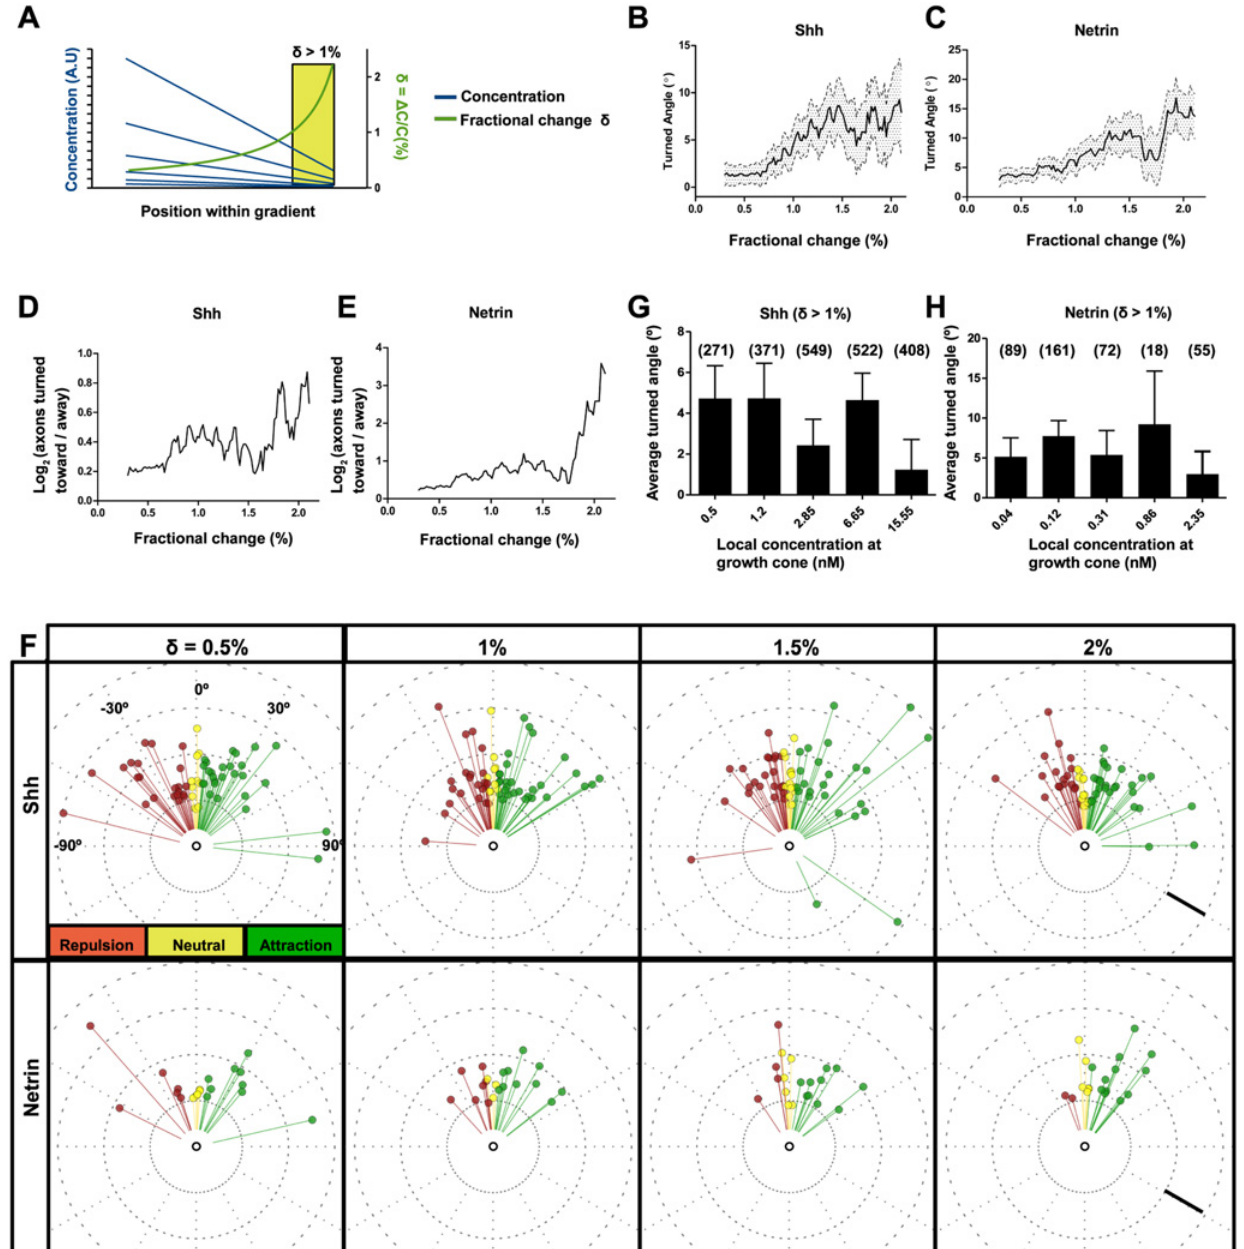
Fig 4. Commissural axon turning depends more on the gradient fractional change than the concentration. (A) Schematic of the concentration gradient within the microfluidic chamber. Because the concentration gradient is linear, the fractional change, δ , is highest when the concentration is low. Regardless of the maximum concentration used, the fractional change at a given position in the chamber is the same. (B – E) Both (B) Shh and (C) Netrin-1 gradients induce more turning as the fractional change increases. The average turned angle is plotted as a function of a moving window of 0.5% fractional change. Error bands represent mean and error of all neurons within the window at each position. The slope of the linear regression was 4.5 ± 2.0 degrees/% for Shh and 6.5 ± 2.4 degrees/% for Netrin. This increased turning response corresponds to an increase in the ratio of axons which turned in the correct direction in (D) Shh and (E) Netrin-1 gradients. (Shh: 43 < n (cid:1) 1,302; Netrin: 17 < n (cid:1) 569 from (cid:3) 4 independent microfluidic devices). (F) Circular distribution of individual turned angles. A random sample of 60 axons for Shh and 20 axons for Netrin-1 are plotted. For either cue, as the fractional change increases, turning is more robust, with a clear bias in the distribution of turned angles towards attraction and a decrease in the proportion of guidance errors. (G, H) For fractional change δ > 1%, there is no improvement in turning with increasing absolute local concentration of (G) Shh or (H) Netrin-1 at the growth cone. The number of axons in each group is indicated in parentheses. One-way ANOVA with Newman Keuls ’ multiple comparison test indicated no significant differences between the groups. Scale bar (F) : 25 μ m. Error bars represent